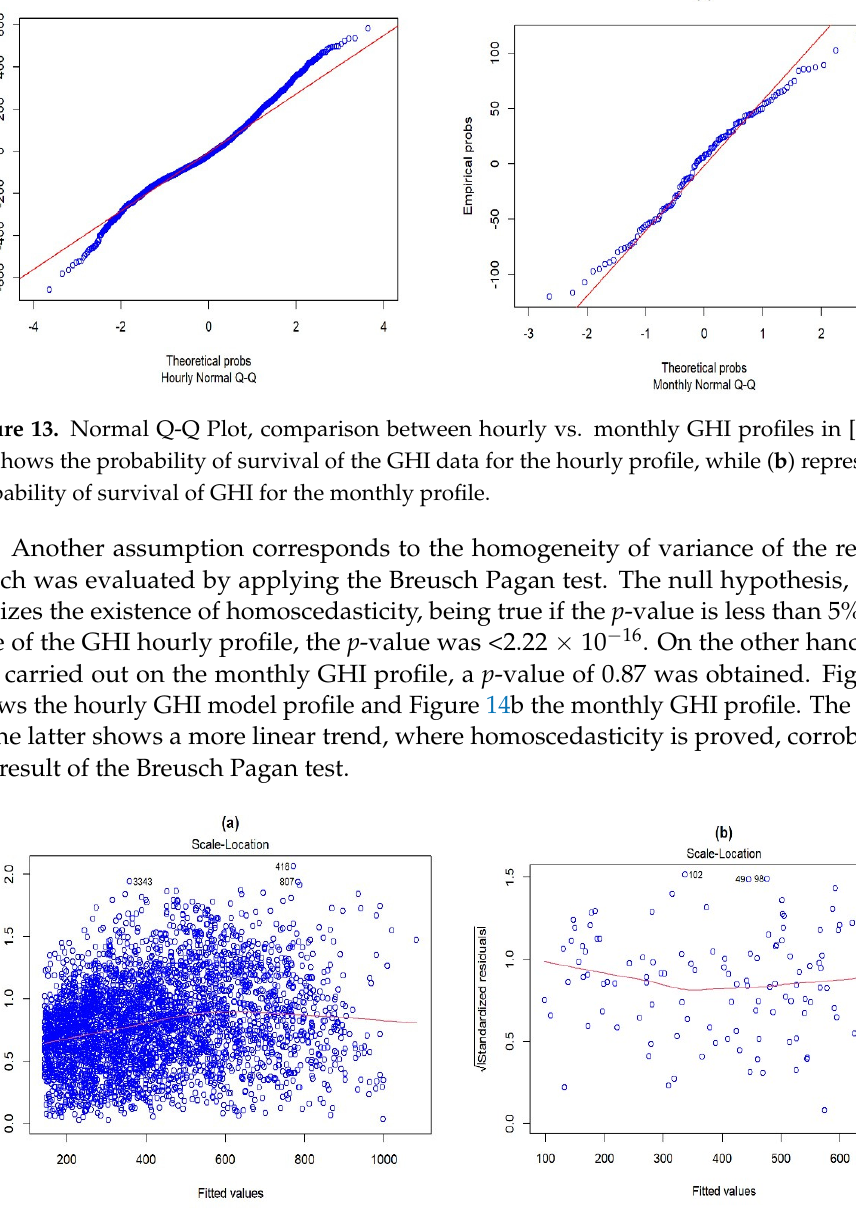
Figure 14. Homoscedasticity scatterplot of the hourly vs. monthly GHI profiles in [W m − 2 ]. ( a ) Shows the variance of the residuals for the hourly GHI profile, while ( b ) shows the variance of the residuals for the monthly GHI profile.